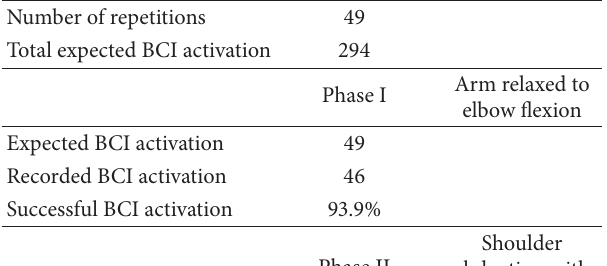
Table 3: Performance for lateral